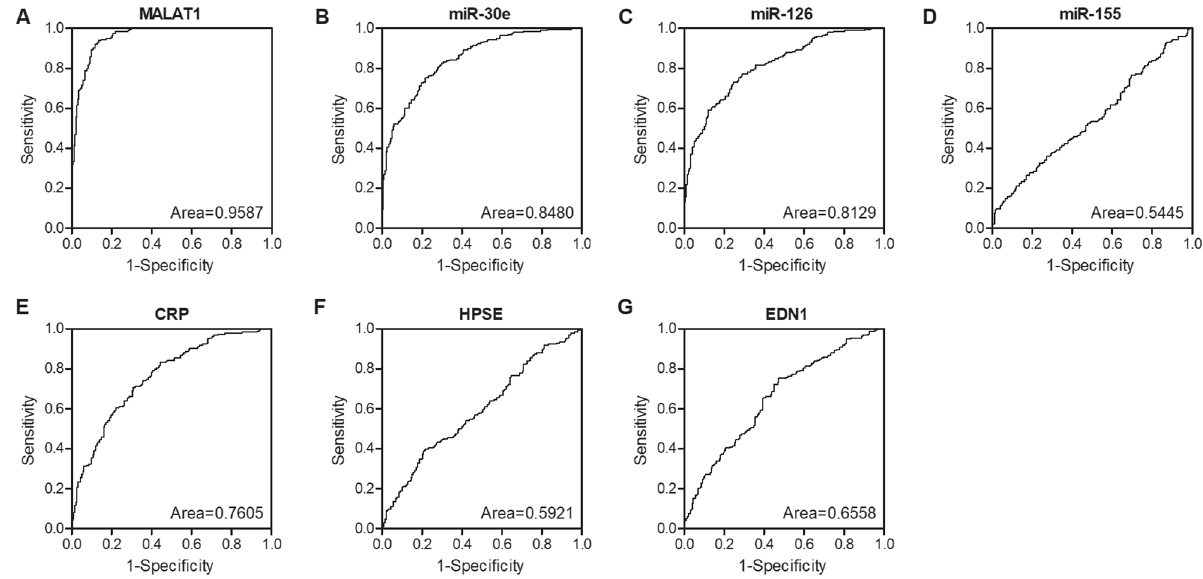
Figure 2. ROC analysis showed considerable efficiency of MALAT1, miR-30e, miR-126 and CRP to differentiate normal reflow and no-reflow in STEMI patients receiving pPCI. ( A ) ROC analysis of MALAT1 expression in differentiating normal reflow and no-reflow in STEMI patients receiving pPCI (95% confidence interval: 0.94 to 0.98; P value < 0.0001). ( B ) ROC analysis of miR-30e expression in differentiating normal reflow and no-reflow in STEMI patients receiving pPCI (95% confidence interval: 0.81 to 0.88; P value < 0.0001). ( C ) ROC analysis of miR-126 expression in differentiating normal reflow and no-reflow in STEMI patients receiving PCI (95% confidence interval: 0.77 to 0.85; P value < 0.0001). ( D ) ROC analysis of miR-155 expression in differentiating normal reflow and no-reflow in STEMI patients receiving pPCI (95% confidence interval: 0.49 to 0.60; P value = 0.1257). ( E ) ROC analysis of CRP expression in differentiating normal reflow and no-reflow in STEMI patients receiving pPCI (95% confidence interval: 0.81 to 0.80; P value < 0.0001). ( F ) ROC analysis of HPSE expression in differentiating normal reflow and no-reflow in STEMI patients receiving pPCI (95% confidence interval: 0.54 to 0.65; P value = 001,525). ( G ) ROC analysis of EDN1 expression in differentiating normal reflow and no-reflow in STEMI patients receiving pPCI (95% confidence interval: 0.60 to 0.71; P value <